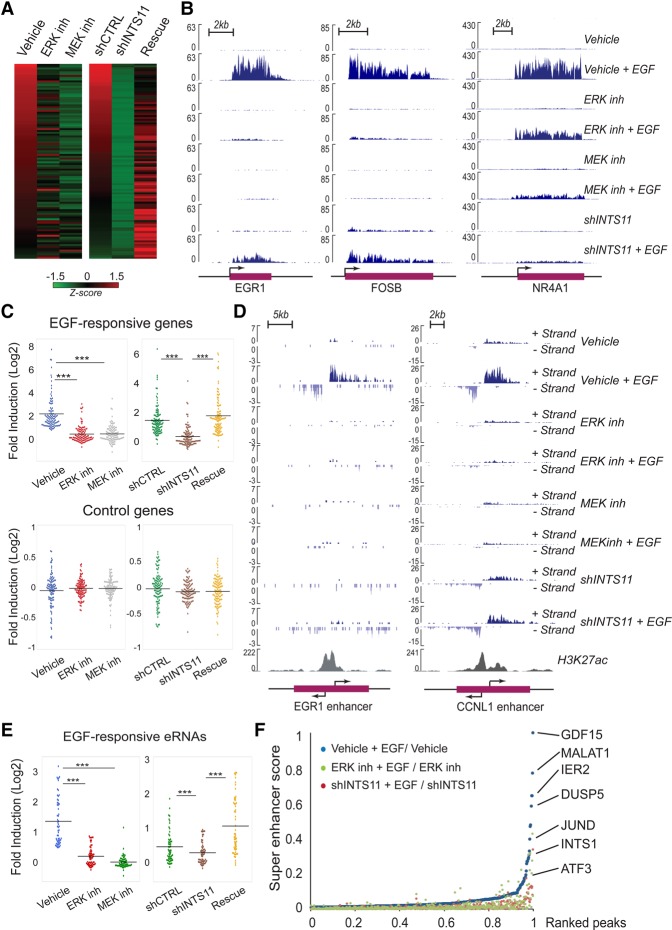
Integrator orchestrates the MAPK-mediated transcriptional response. All genome-wide analyses were performed in at least duplicate biological repeats. (A) Heat map representing the fold induction of 106 EGF-induced genes in HeLa cells following treatment with vehicle, ERK inhibitor (SCH772984), MEK inhibitor (PD0325901), or shCTRL, shRNA against INTS11 and INTS11 overexpression (rescue). Each lane represents the fold ratio of gene expression changes before and after 20 min of EGF stimulation. The heat maps are ranked from the highest to the lowest fold induction of EGF-responsive genes. All genes were induced by at least twofold. FPKM (fragments per kilobase per million mapped fragments) > 1; q-value < 0.05. Z-scores are scaled across rows. The EGF-induced genes are listed in Supplemental Table S1. (B) EGF-induced gene expression at EGR1, FOSB, and NR4A1 loci were diminished by the presence of ERK inhibitor, MEK inhibitor, or shRNA against INTS11, as revealed by ChromRNA-seq. The Y-axis represents the read counts normalized to sequencing depth. (C) Dot plots represent significant impairments of EGF responsiveness caused by ERK, MEK inhibition, or INTS11 knockdown. Average expression level of 106 EGF-induced genes or control genes were measured by fold induction after EGF treatment. (***) P < 0.001 for all comparisons, t-test. (D) ERK inhibition or knockdown of INTS11 restrains the activation of EGF-responsive enhancers adjacent to EGR1 and CCNL1 gene loci. (E) Dot plots indicate similar inhibition of 57 EGF-induced eRNAs by ERK inhibition, MEK inhibition, or INTS11 knockdown. (***) P < 0.001 for corresponding comparisons, t-test. The EGF-induced eRNAs are listed in Supplemental Table S2. (F) The activation of enhancers and superenhancers (SEs) were repressed by ERK inhibition (green) or INTS11 knockdown (red). A full description is in the Materials and Methods. The EGF-induced SEs are listed in Supplemental Table S3.